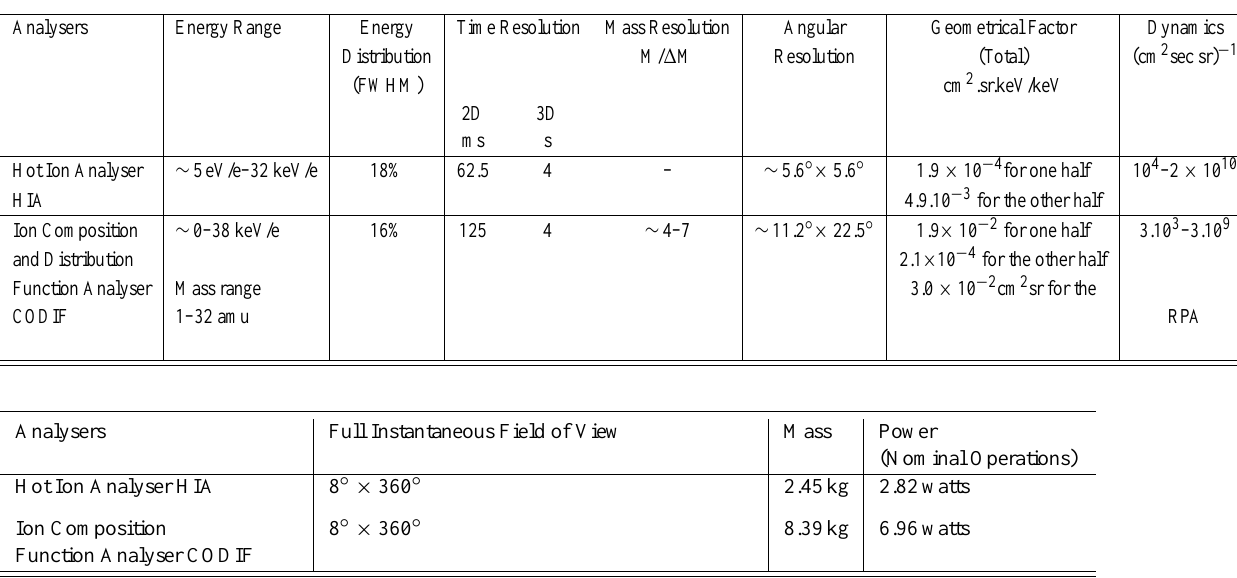
Table 2. Main features and measured parameters of the CIS experiment Full 3D ion distribution